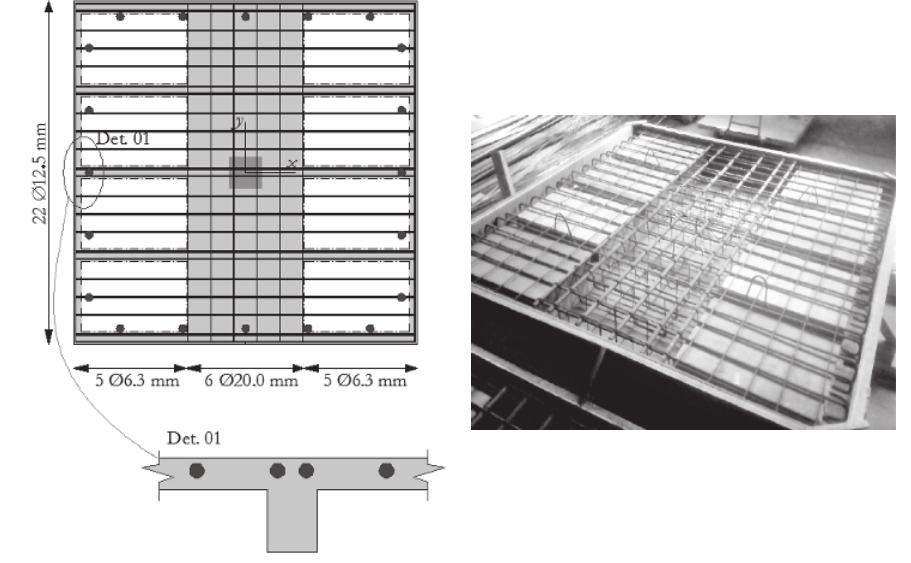
Detalhes da armadura de flexão das lajes